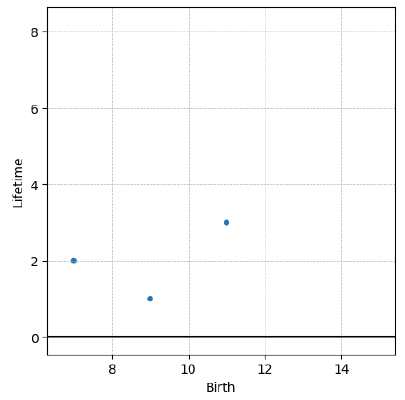
Figure 4. Lifetime diagram LT